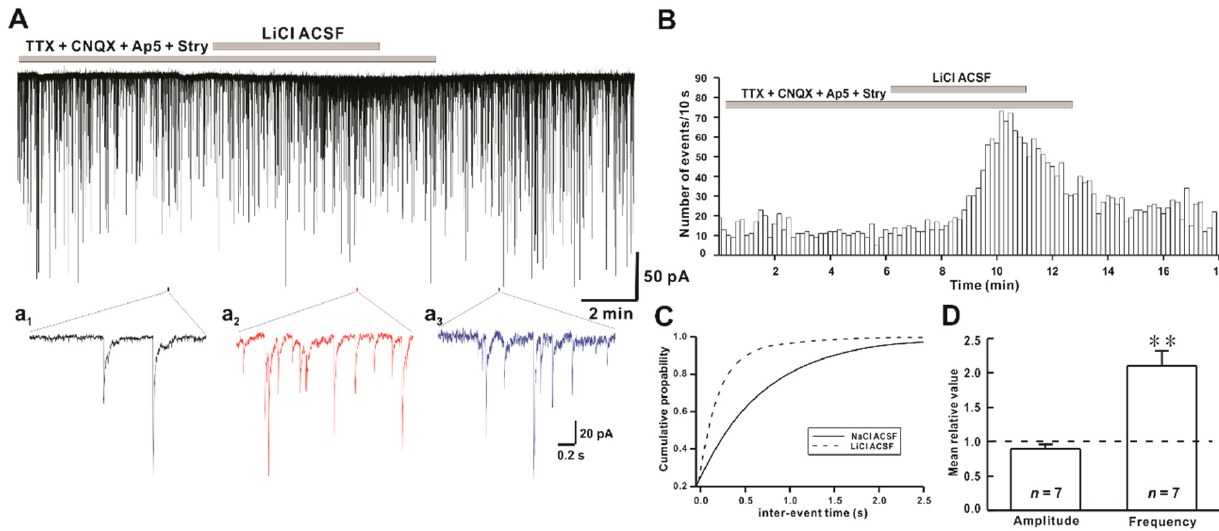
Figure 3. Effect of Li + on GABAergic mIPSCs on hPOA neurons. ( A ) A representative current trace of GABAergic mIPSCs recorded in the presence of Na + and Li + ACSF on hPOA neuron. ( a 1 – a 3 ), sections of the current trace in Figure 3A show GABAergic mIPSCs before, during, and after perfusion of Li + at 2-s intervals, respectively. ( B ) A spike frequency histogram of the trace in Figure 3A. ( C ) A cumulative probability plot of GABAergic mIPSCs inter-event interval (IEI) in the presence of Na + (solid line) and Li + (dotted line). Note that the cumulative probability curve was left-shifted by Li + , indicating the increase of GABAergic mIPSCs frequency (Kolmogorov-Smirnov test, p < 0.05). ( D ) Mean relative amplitude and frequency of GABAergic mIPSCs in LiCl ACSF compared to NaCl ACSF (** p < 0.01 by paired t ‐ test).